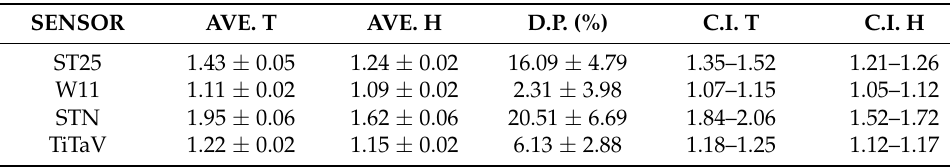
Table 1. Average sensor responses statistical analysis.